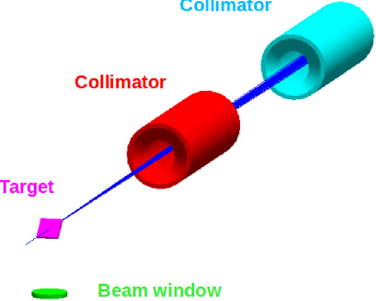
FIG. 5. G EANT 4 modeling of the ISIS muon target, beam window, and collimators. The target is tilted at 45 degrees and the muons produced in the target are collected by the beam window. The transmitted proton beam passes through the collimation system and impacts further on the neutron target situated 20 m